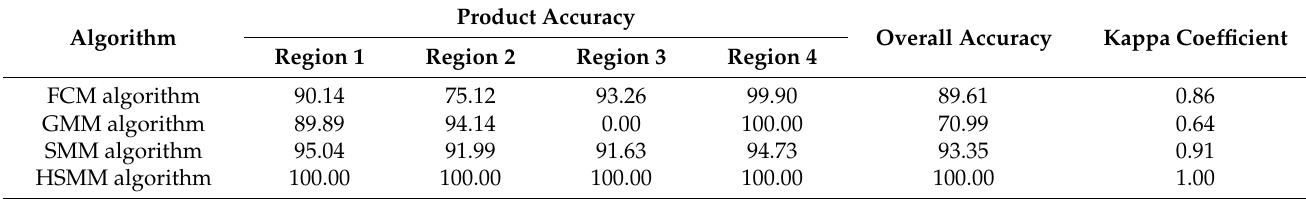
Table 3. The segmentation accuracy of the noise multispectral synthetic